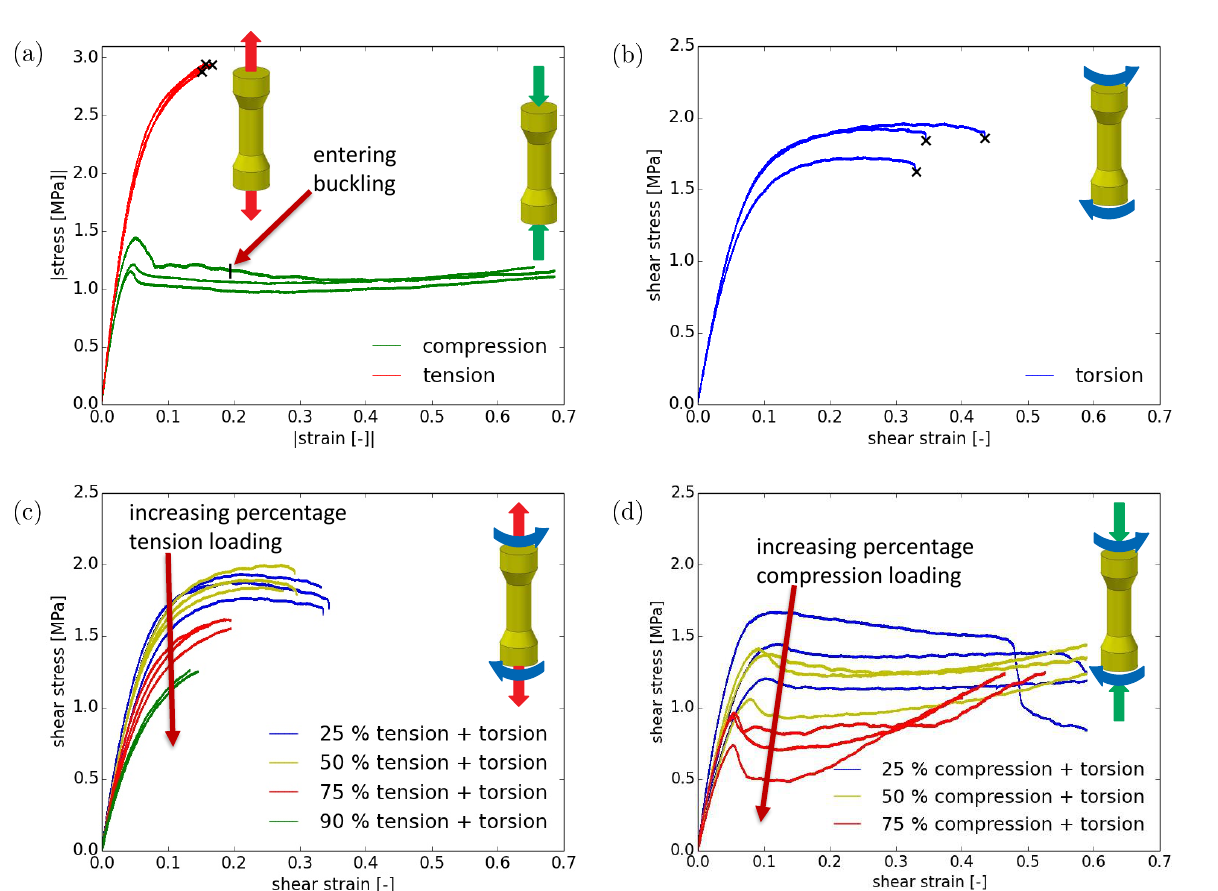
Figure 2. Stress-strain diagrams for the tension tests and the compression tests (a) and the shear stress-shear strain diagrams for the torsion tests (b), the combined tension-torsion tests (c) and the combined compression-torsion tests (d).